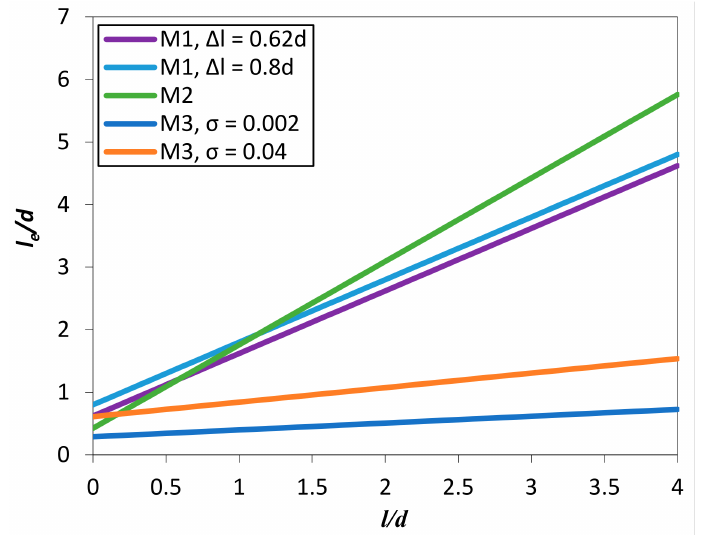
Figure 15. The dependence of the dimensionless effective length as a function of the dimensionless orifice